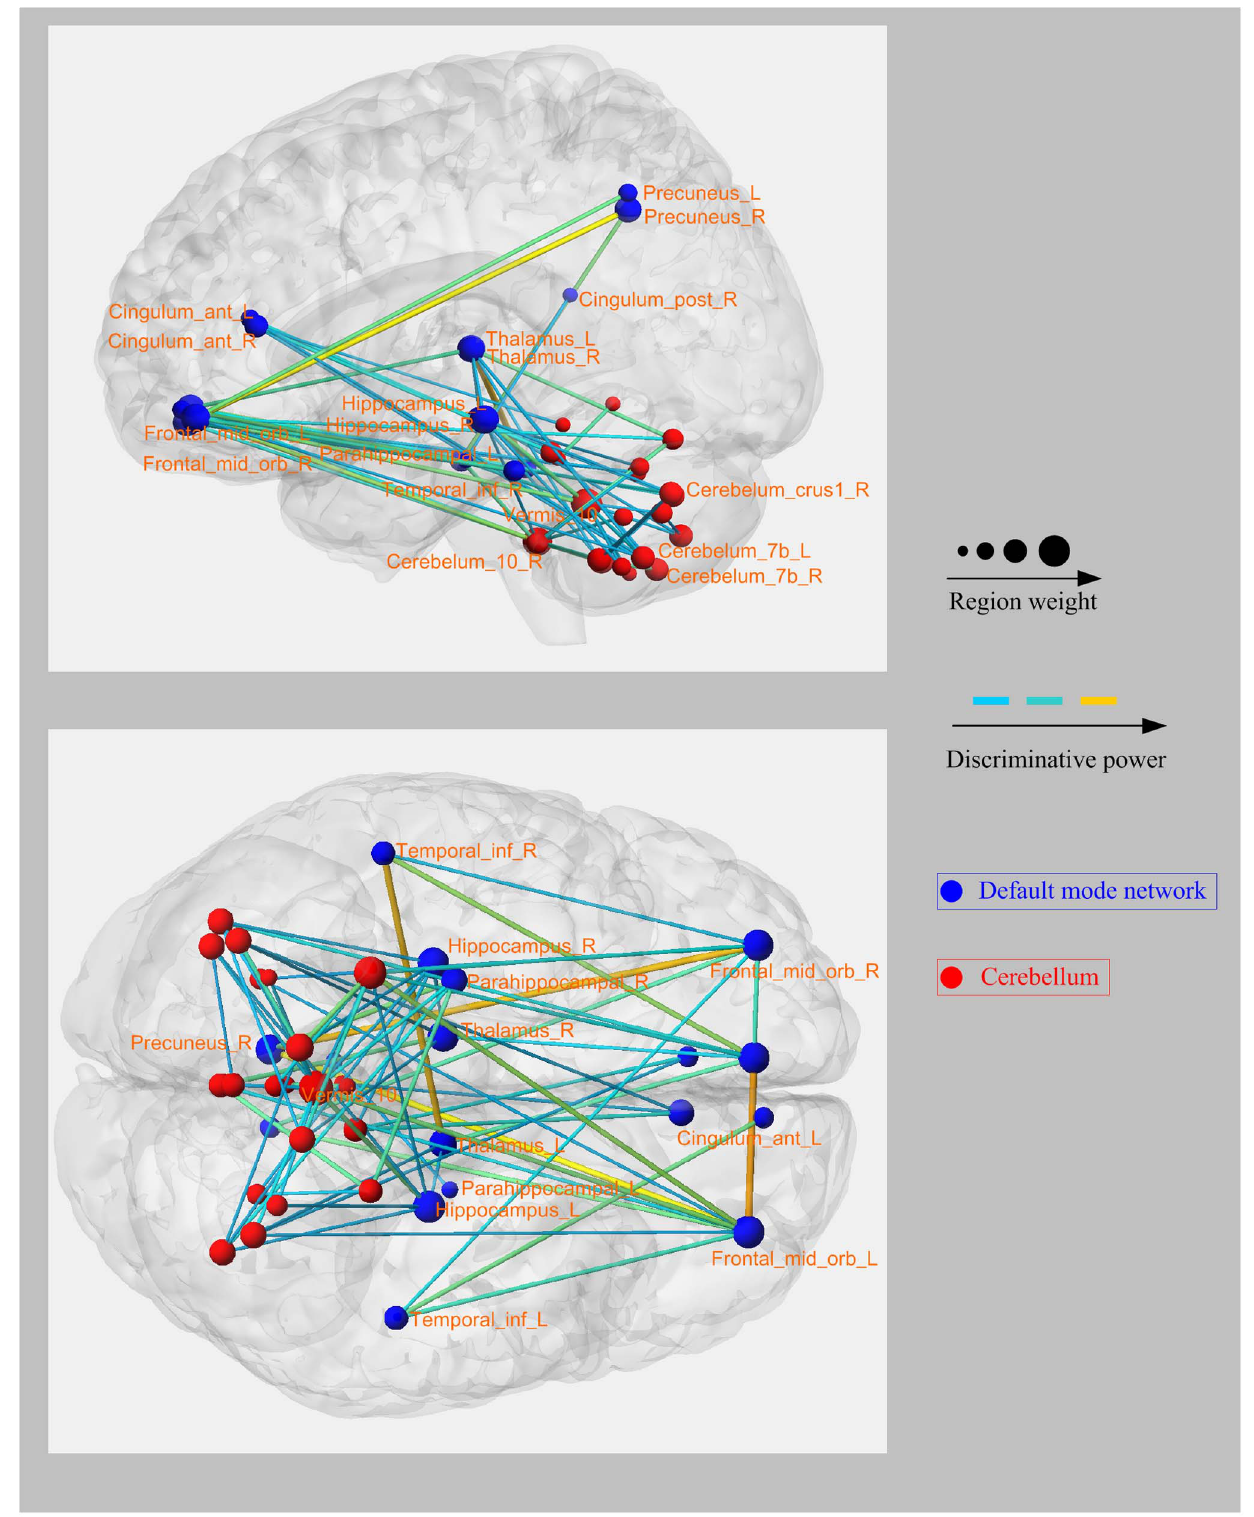
Figure 4. Left and bottom views of the convergent functional connectivity patterns with high discriminative power. Regions are color-coded by category. The line colors representing the discriminative power of the relative connections are scaled with their mean discriminative power in the leave-one-out cross-validation.